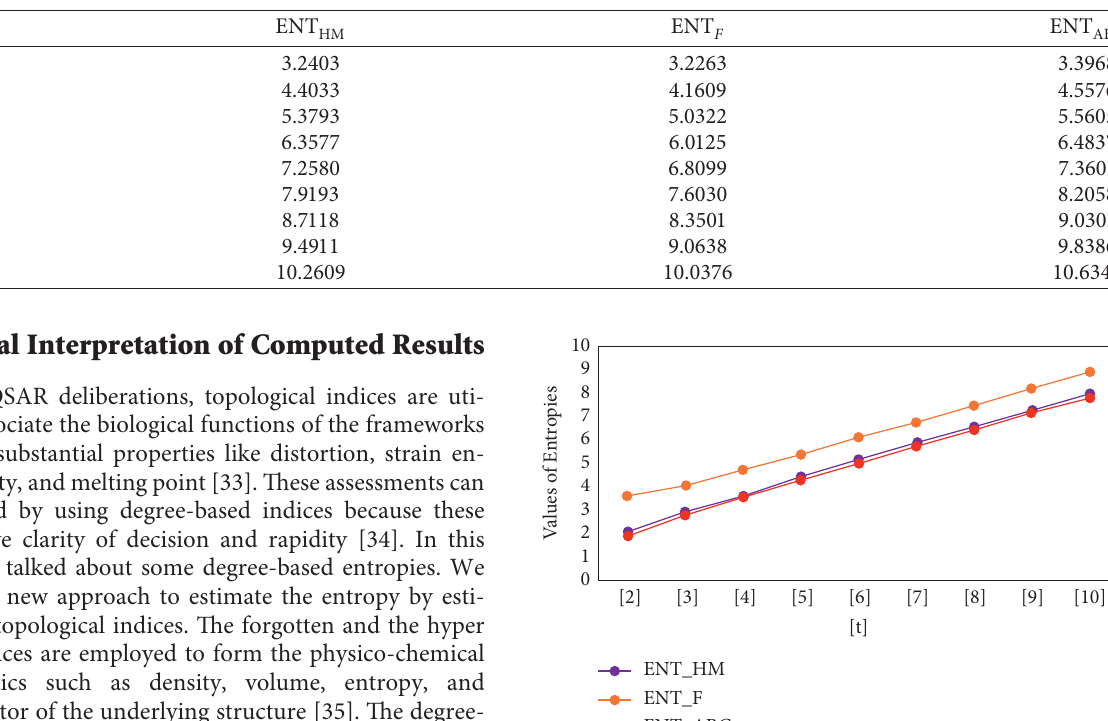
Table 8: Comparison of degree-based entropies ENT